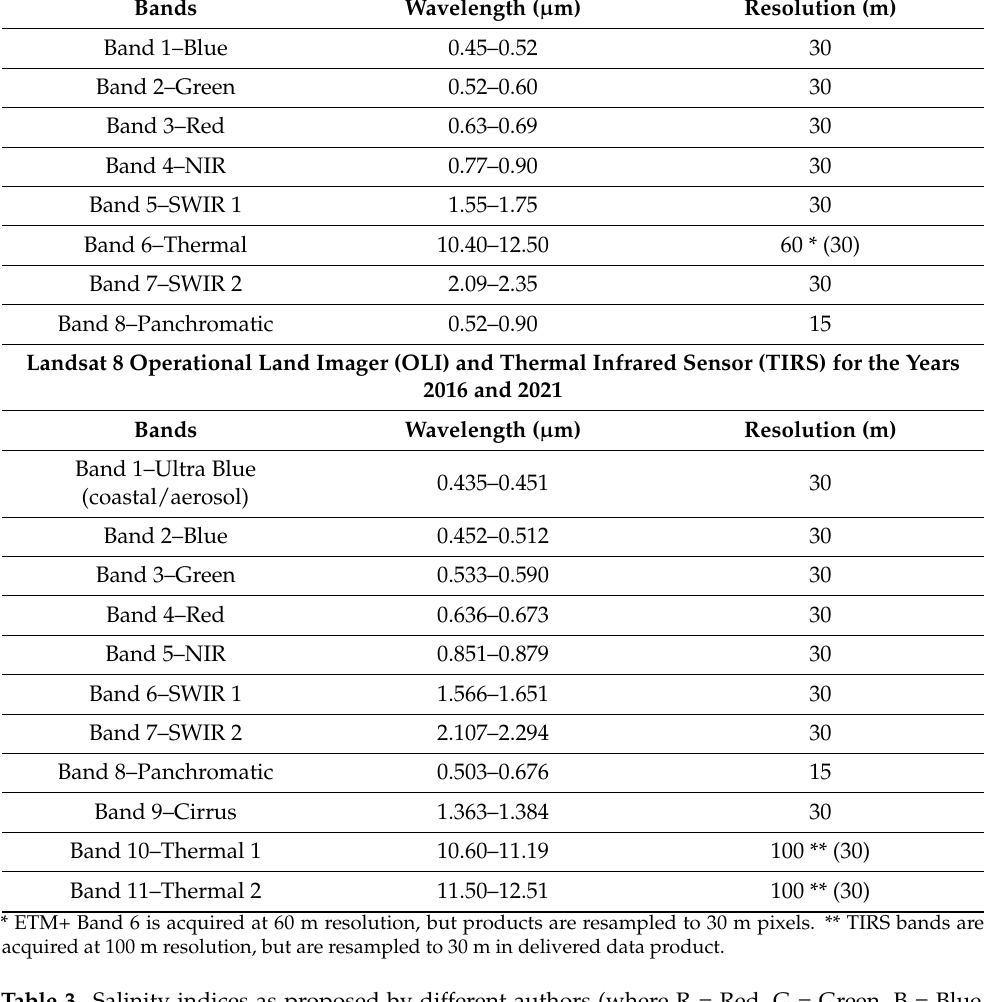
Table 3. Salinity indices as proposed by different authors (where R = Red, G = Green, B = Blue, NIR = Near-Infrared, and SI = Salinity Index).